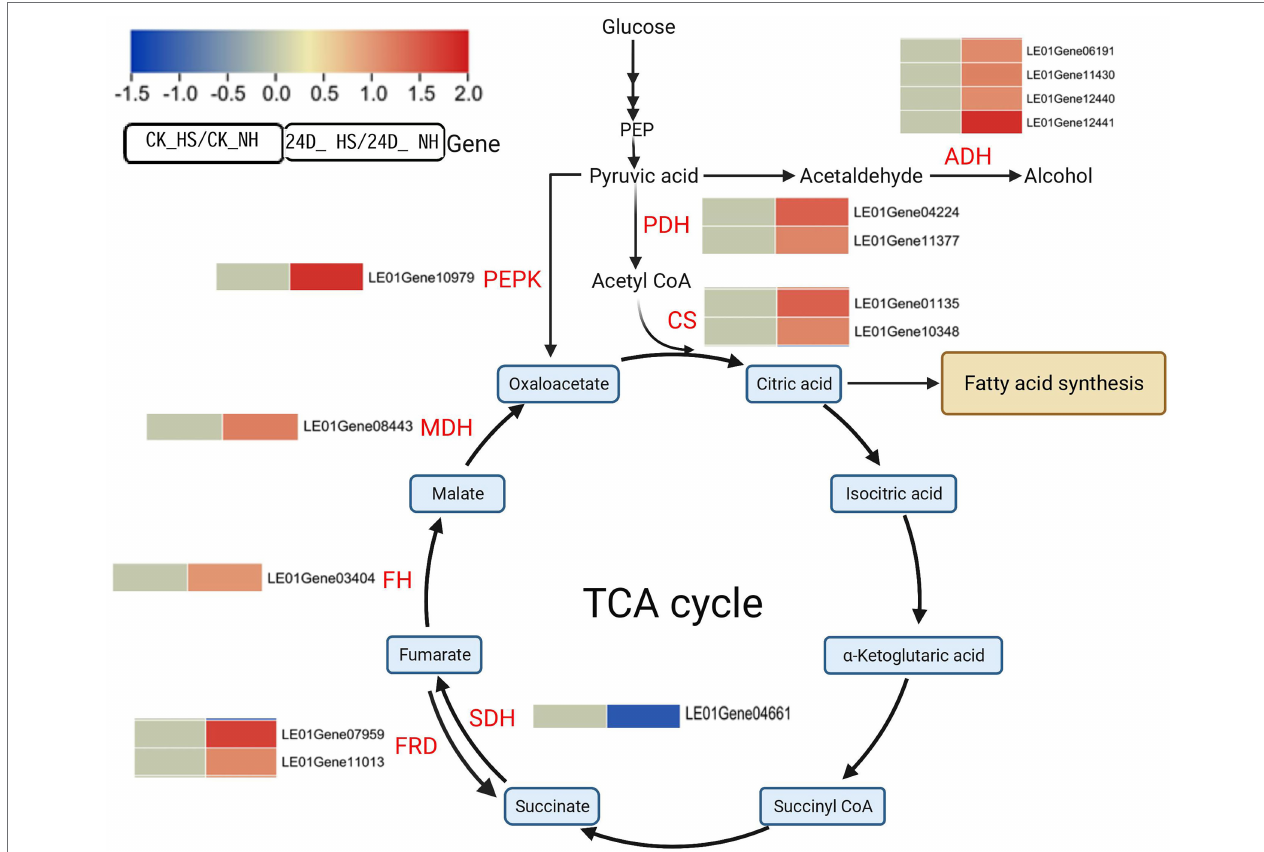
FIGURE 3 | Effects of 2,4-D and heat stress on the expression of genes related to the TCA cycle. Enzyme names are in red font and metabolites are in black font. Red and blue squares represent up-regulation and down-regulation, respectively. Solid lines and multiple solid arrows indicate single- and multi-step reactions, respectively. Beside the name of the enzyme is the corresponding gene ID. The same row in the heat map indicates changes in gene abundance in CK_HS/CK_NH (left column) and 24D_ HS/24D_ NH (right column), followed by the gene ID. Genes with no differential expression are indicated by 0 in the heatmap. PEPK, phosphoenolpyruvate carboxykinase; ADH, alcohol dehydrogenase; PDH, pyruvate dehydrogenase; CS, citrate synthase; SDH, succinate dehydrogenase; FRD, fumarate reductase; FRD, fumarate reductase; FH, fumarate hydratase; MDH, malate dehydrogenase. This graph is created with